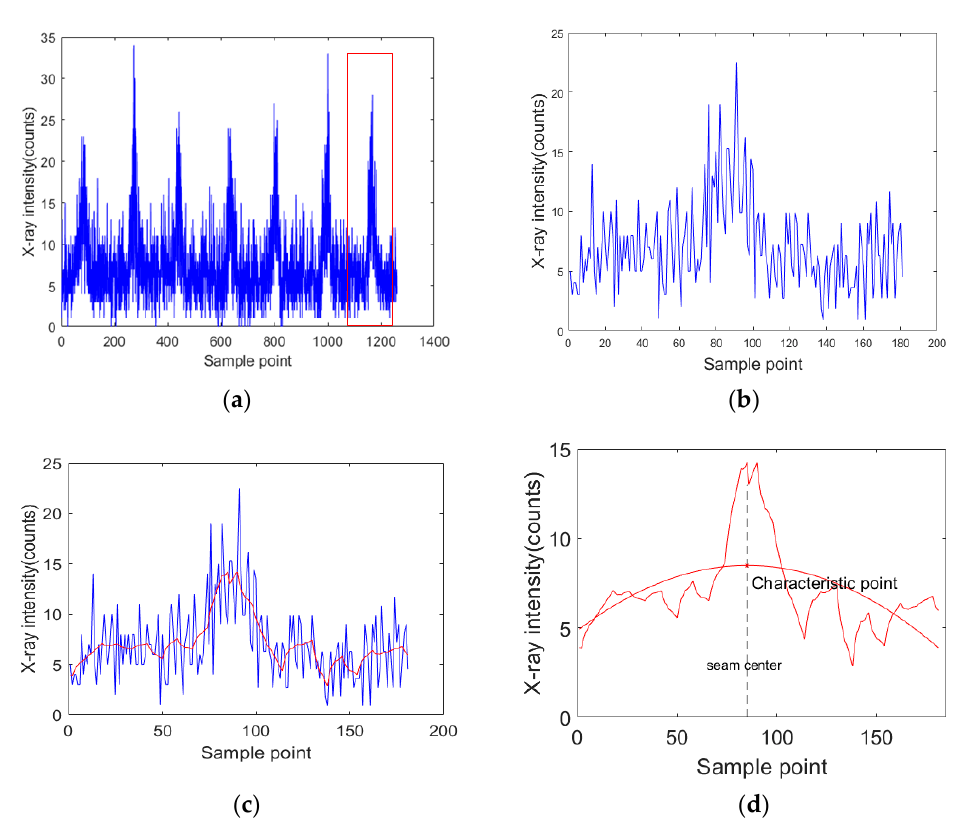
Figure 10. The whole procedure of X-ray intensity signal processing for single scanning period: ( a ) original signal; ( b ) read signals in single scanning period; ( c ) denoising; ( d ) curve fitting. Table 1. Comparison of detection error after signal processing.